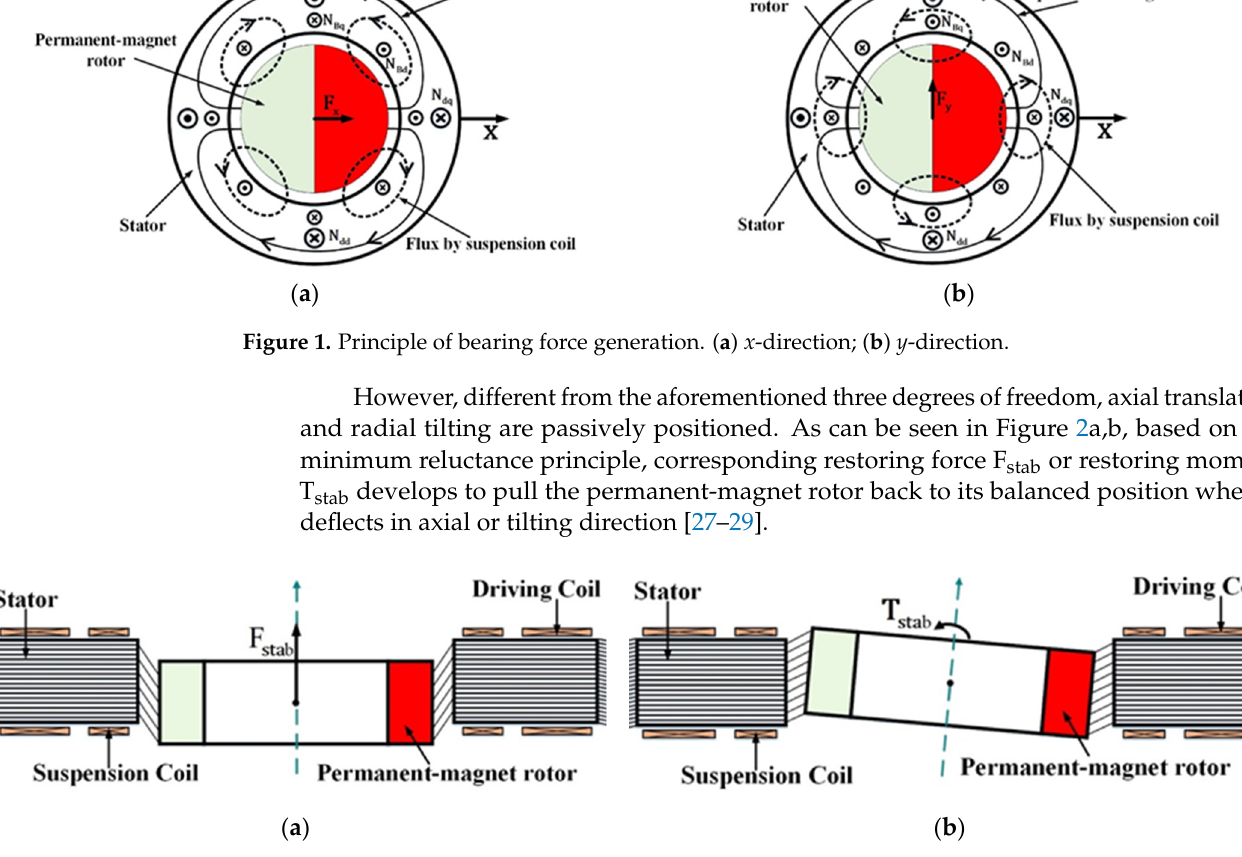
Figure 2. Passive stability. ( a ) axial direction; ( b ) tilting direction.